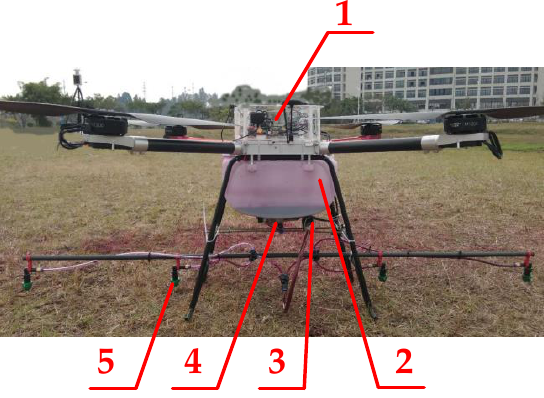
Figure 6. Physical diagram of the variable spraying system. Note: 1. Prescription map interpretation system and spray controller; 2. medicine case; 3. Hall flow sensor; 4. miniature diaphragm pump; 5. pressure nozzle.